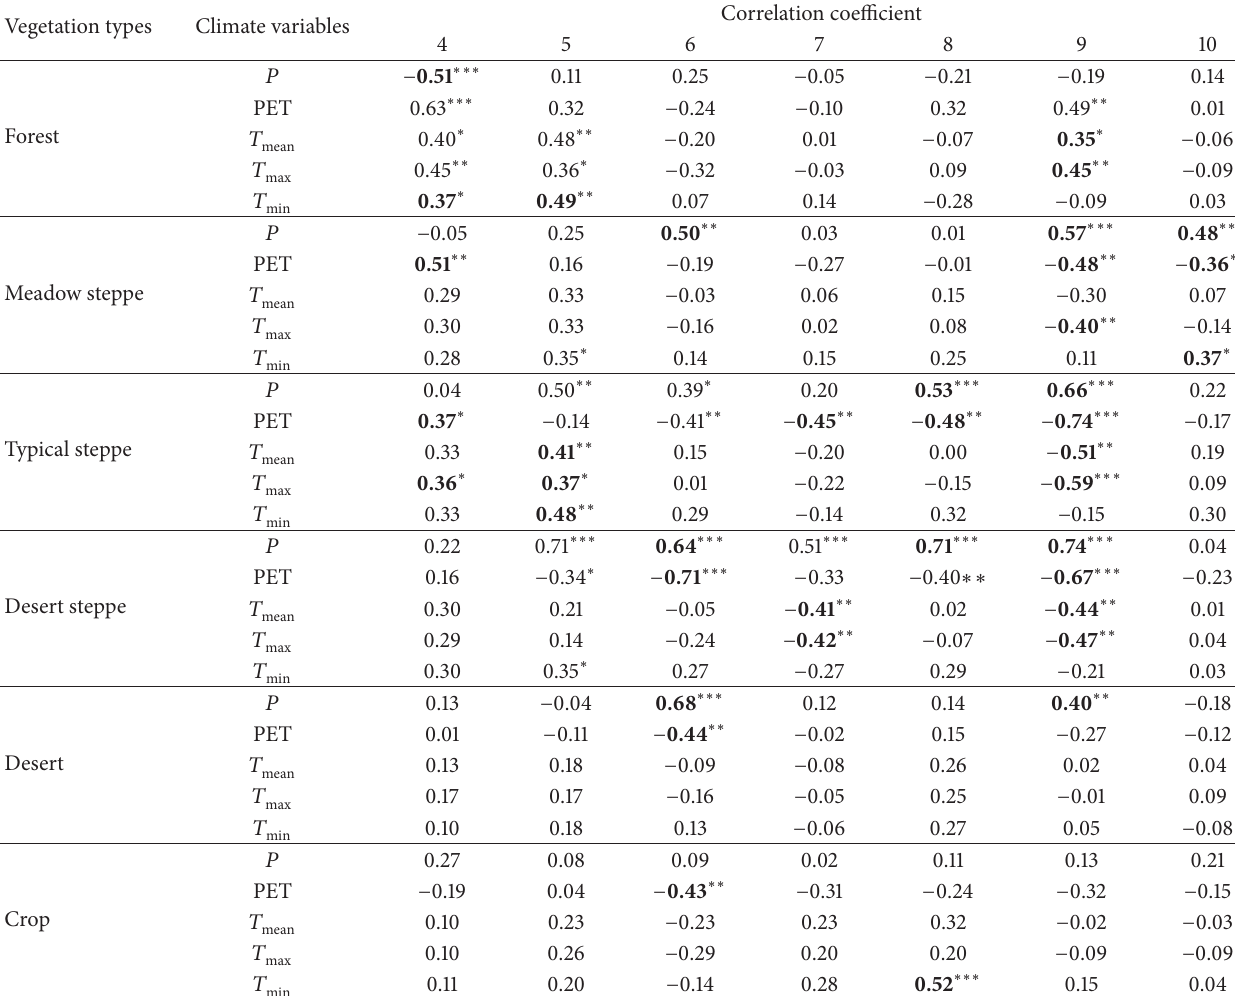
Table 3: Correlation coefficients between monthly mean NDVI and 𝑃 , PET, 𝑇 vegetation types. Vegetation